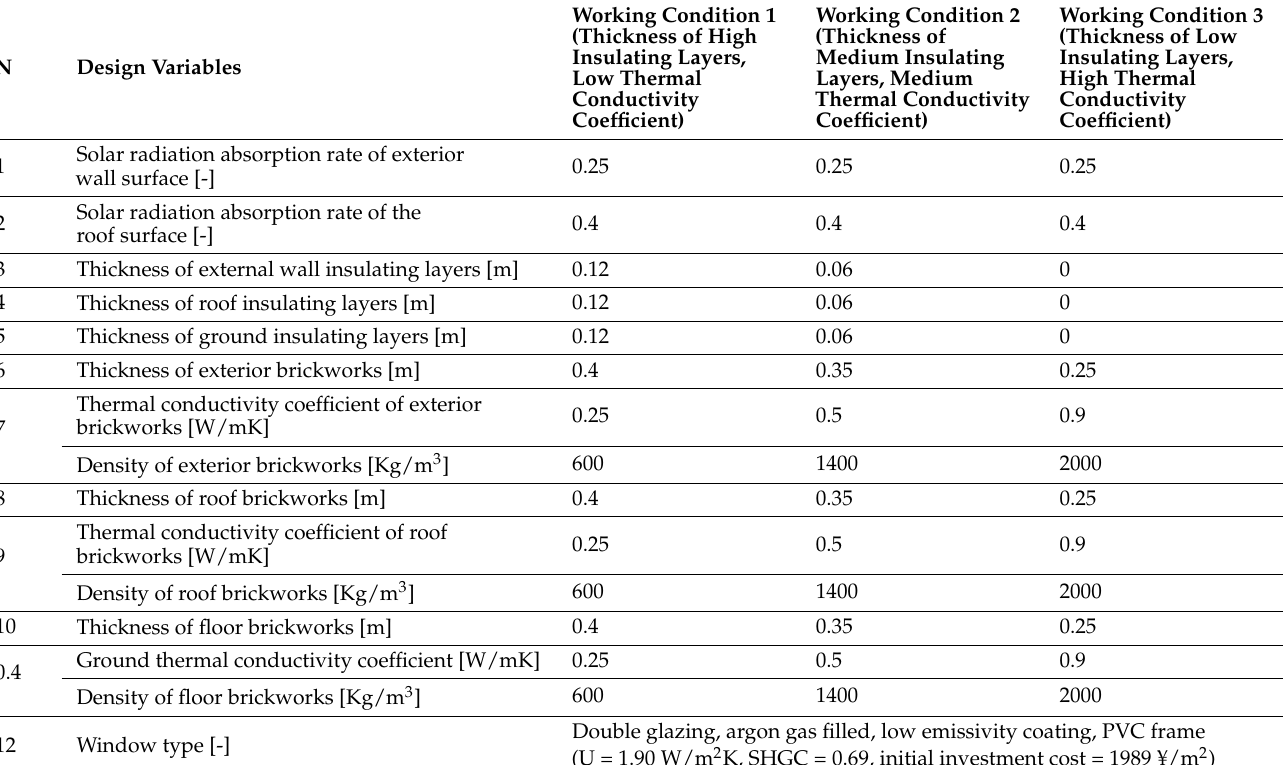
Table 6. Three types of parameter settings of working conditions for the building envelope of low-rise and medium-rise residential buildings.